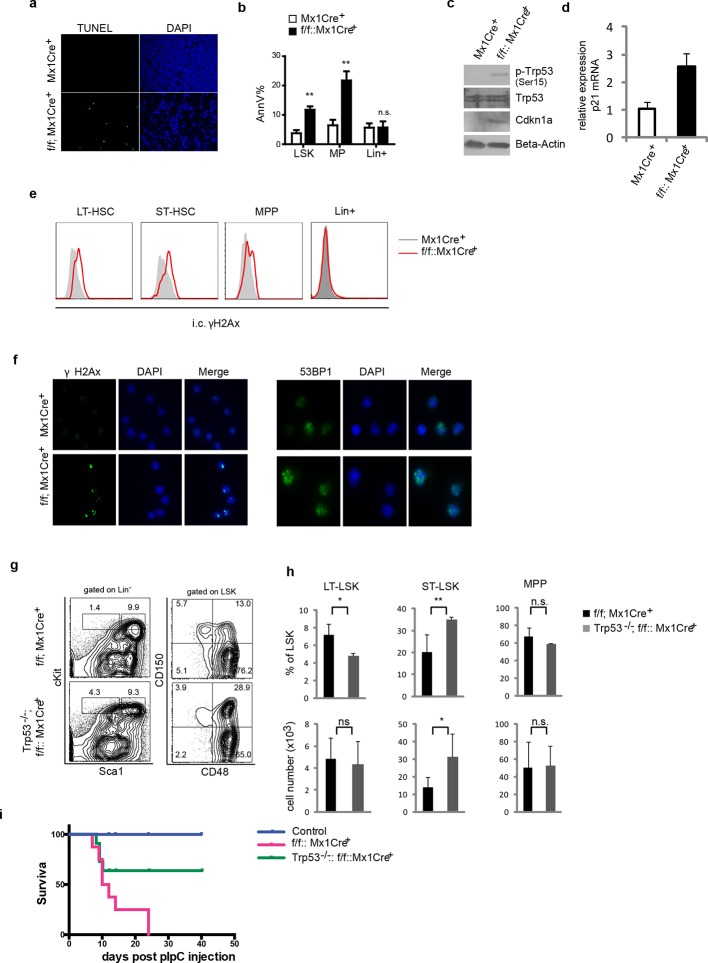
Ddb1 deletion induces DNA damage and apoptosis in progenitor cells.(a) TUNEL staining on tibia sections after polyI:C injection. (b) Percentage of AnnexinV+ cells gated on different populations after polyI:C injection. Western blot (c) and qPCR (d) in lineage negative bone marrows after polyI:C injection. (e) Histogram of intracellular γH2Ax staining gated on HSPC sub-populations and lineage positive cells after polyI:C injection. (f) Immunofluoresence staining of γH2Ax and 53BP1 on flow-sorted LSK cells after polyI:C injection. (g) Representative FACS plots of bone marrow cells 5 days post polyI:C injection. (h) Frequency and absolute number of progenitor cells (n = 4 per group). One of 2 independent experiments was shown. *p<0.05. **p<0.01. ***p<0.001. n.s. p>0.05. (i) Survival curves of control, Trp53-/-::Ddb1f/f::MxCre+ mice, and Ddb1f/f::MxCre+ mice (n = 5 per group, one independent experiment). Age matched littermates on a mixed 129xC57BL/6 background were used for g-i.